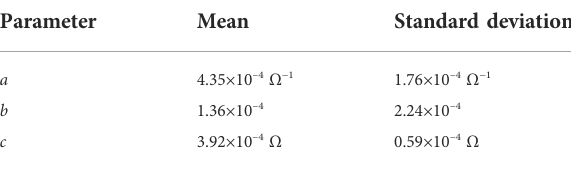
TABLE 2 Means and standard deviations of error model parameters fi tted tothe Site3 reciprocal error distributions at each time-step.